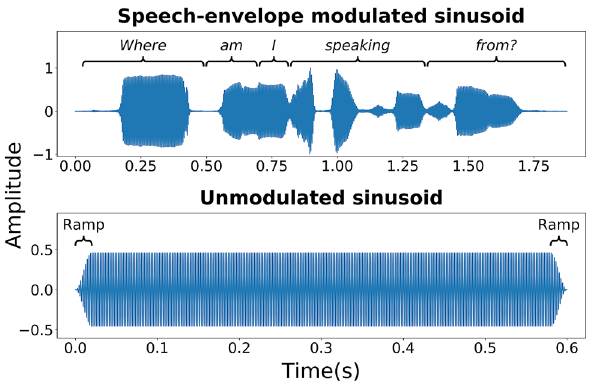
Figure 3. The amplitude envelope (plotted in arbitrary linear units) of the stimuli used in experiment 2. The top panel shows the speech amplitude envelope modulated stimulus (with the sentence text marked above) and the bottom panel shows the unmodulated stimulus (with onset and offset ramps marked above). Both stimuli were sinusoids with a frequency of 250 Hz. This figure was generated using Matplotlib 3.1.3 (https ://matpl otlib